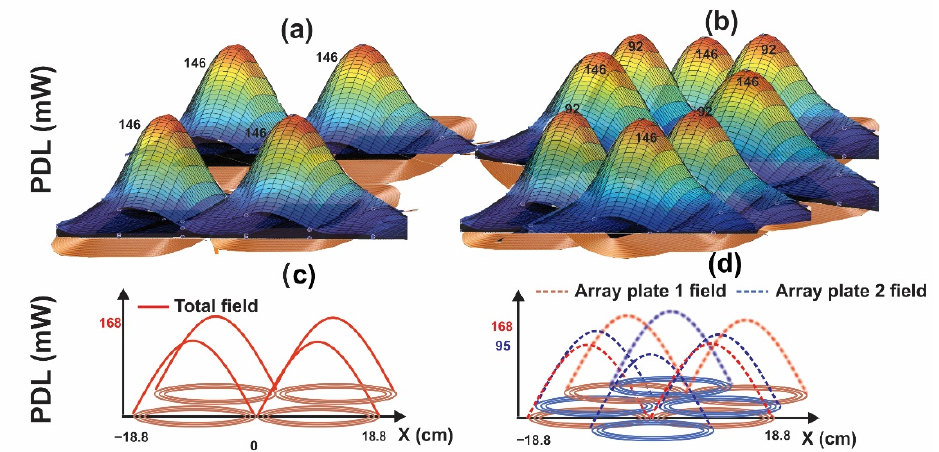
Figure 10. Power distribution and PDL for horizontal ( x - y ) RX Movement between the arrays. ( a ) Conventional array and ( b ) 8-folded star shape array measured PDL peak. ( c ) Conventional arrays and ( d ) 8-folded star shape array PDL peak distribution.